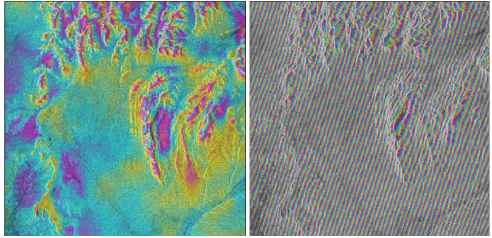
Figure 3. Interference fringe results